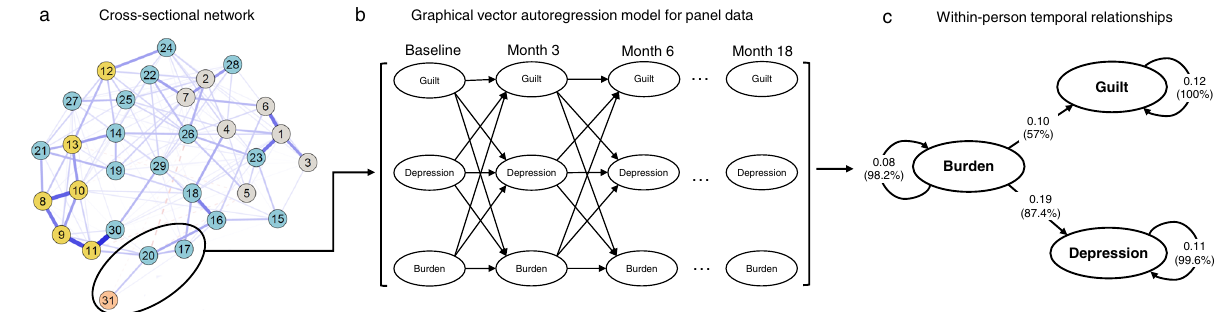
Fig. 2 Longitudinal analysis of the relationship between burden of recent life events, depression and guilt feelings in the early psychosis spectrum ( n = 337). a Focusing on symptoms that showed connections with burden of recent life events in the cross-sectional network, modeled using 30 PANSS items and burden of recent life events, b up to seven equidistant, consecutive measurement occasions, each about three months apart, were used for modeling c the longitudinal relationships between burden of recent life events, depression, and guilt in a graphical vector autoregression model for panel data ( panelgvar ). Parameters re fl ecting the longitudinal relationships were standardized to partial directed correlations. All depicted parameters estimates were signi fi cant ( p < 0.001). The percentages in brackets indicate how often each edge was included across 1000 bootstrap